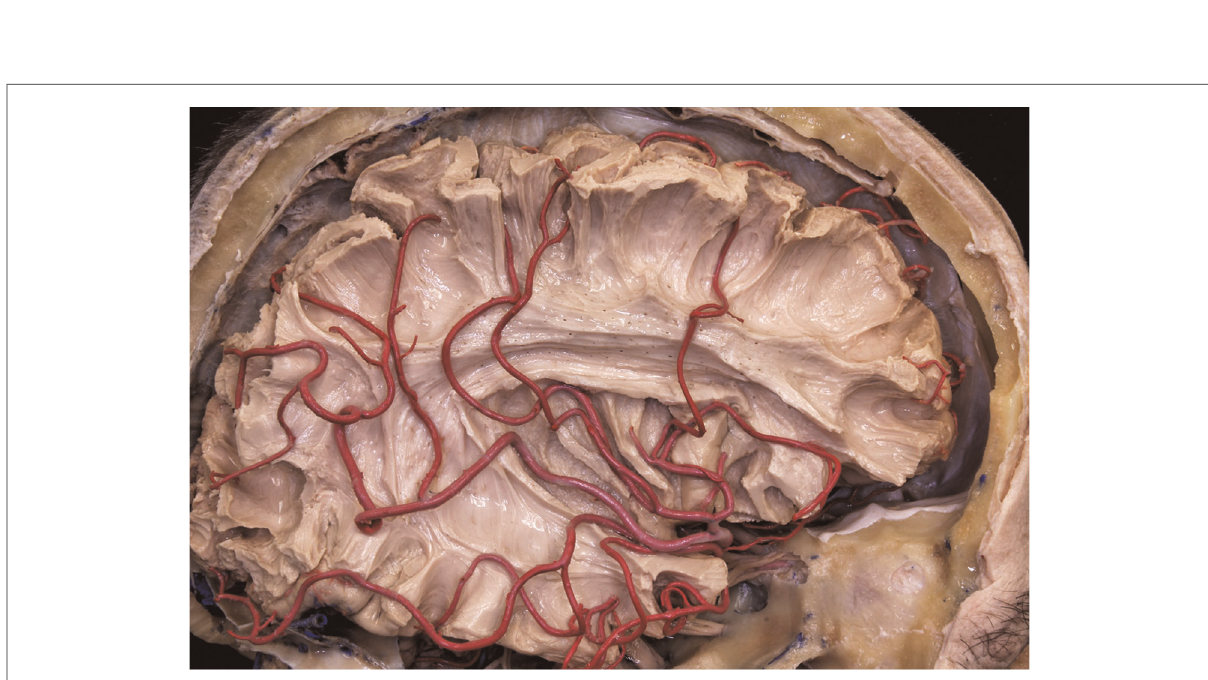
FIGURE 11 The MCA branches pass through the insular surface and irrigate most of the lateral surface of the brain. This is why all arterial branches passing through the insula must be